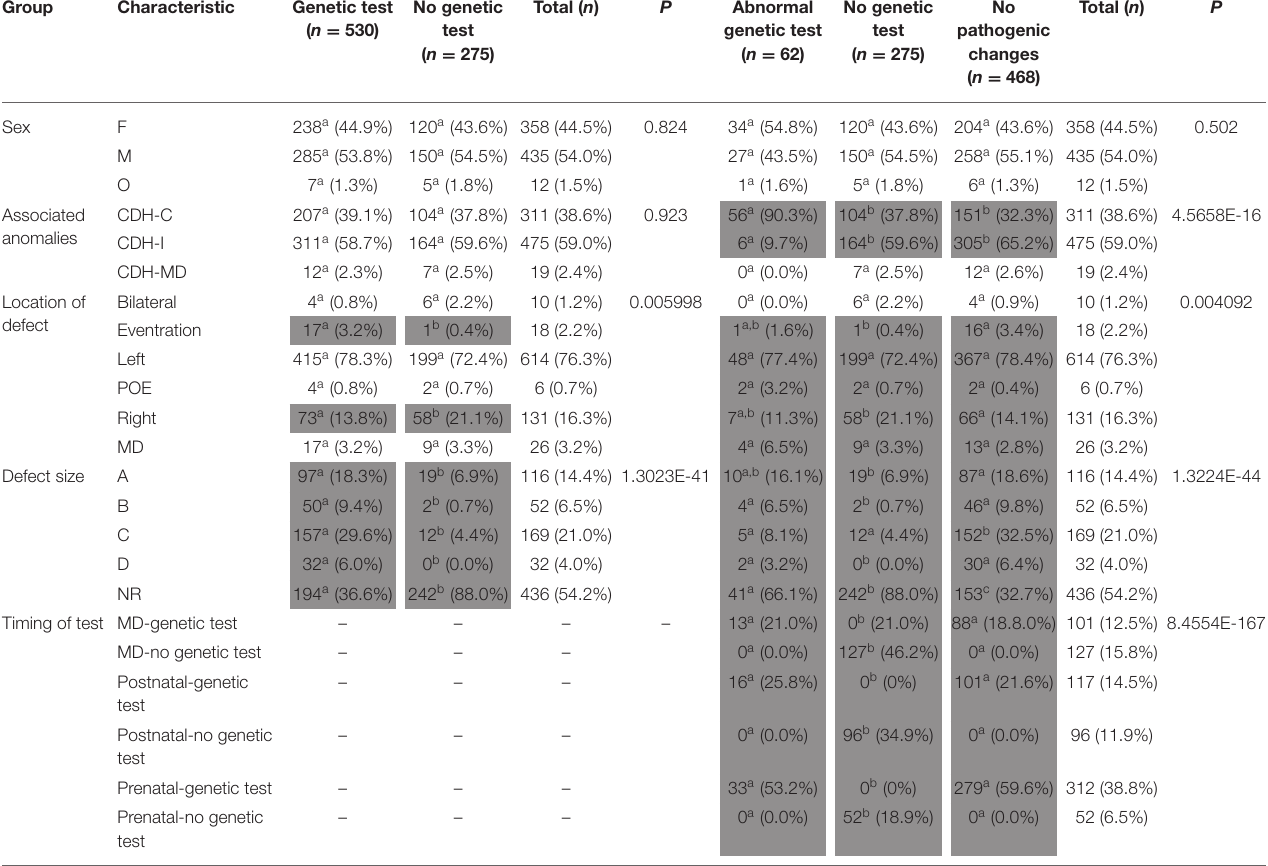
TABLE 3 | Cohort description of output measures and genetic evaluation.